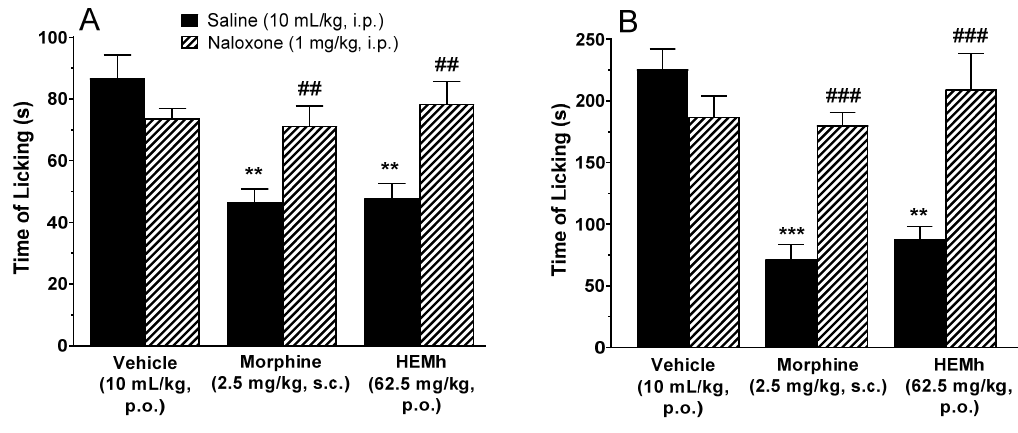
Figure 8. Involvement of the opioid system on antinociceptive activity of hydroalcoholic extract of the twigs of Machaerium hirtum (HEMh) in the formalin test (panel A —neurogenic phase and panel B —inflammatory phase). Each column represents the mean of 6–10 animals and the vertical lines indicates the S.E.M. The asterisks denote the significance levels compared with the vehicle control group (** p < 0.01 and *** p < 0.001) and hashtag denotes the significance levels when comparing the morphine and HEMh treatments with their respective saline group ( ## p < 0.01, ### p < 0.001) using one-way ANOVA (analysis of variance) followed by Tukey’s post hoc test.